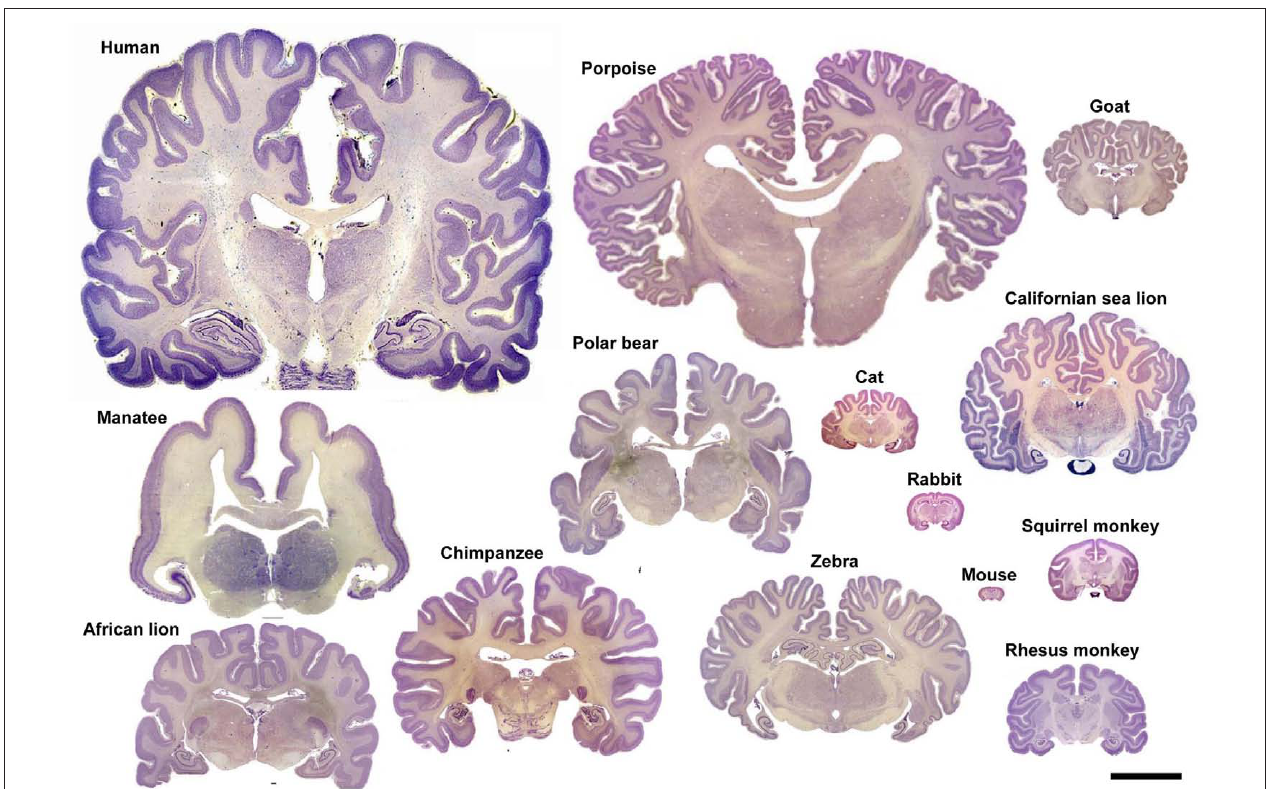
Figure 10 | Variation in brain size and patterns of convolutions. Coronal sections (25–40 μm thick; thionin staining) of the brain of several mammalian species. Adapted with permission from http://www.brains.rad.msu.edu, supported by the US National Science Foundation. Scale bar: 10 cm.